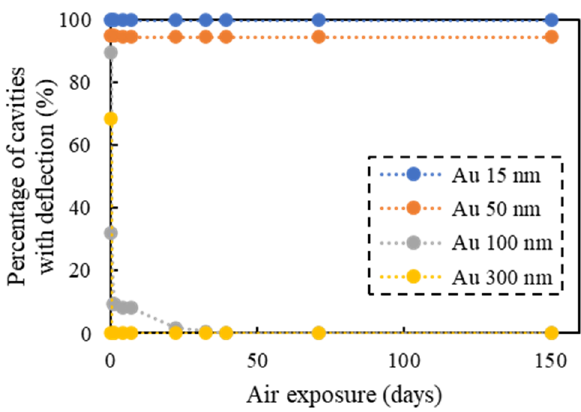
Figure 14. Vacuum sealing results: percentage of cavities with a deflection after air exposure.